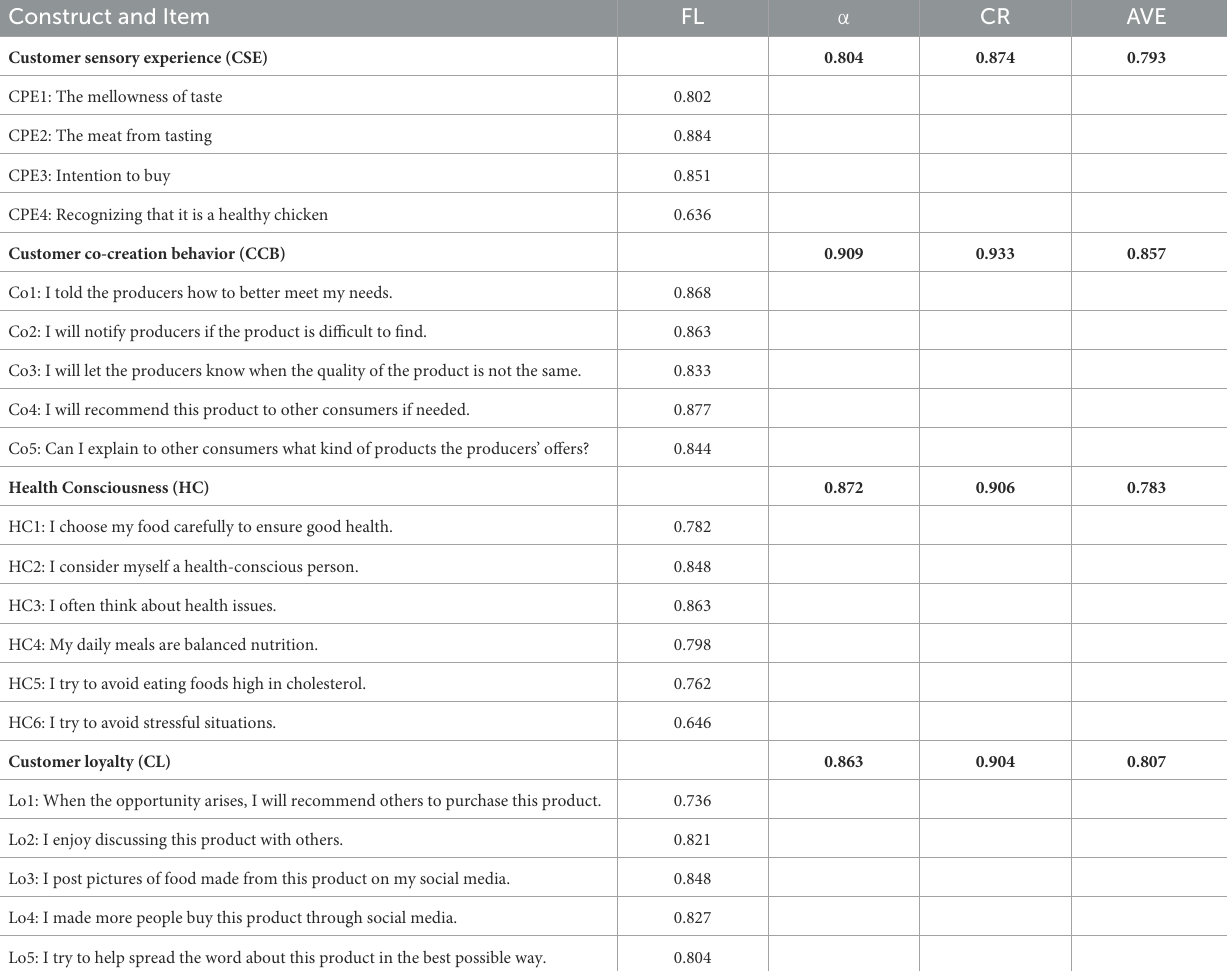
TABLE 1 Results of measurement model analysis ( n = 487). Construct and Item